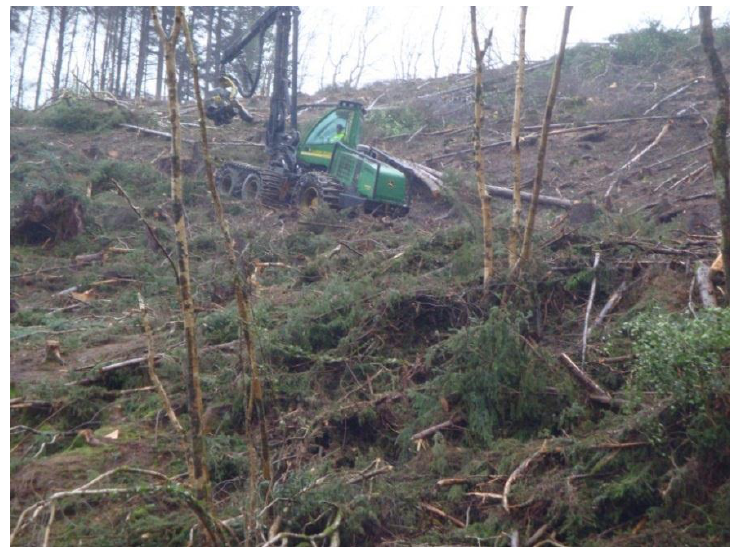
Figure 7. John Deere timber harvester 1410 D on Clonmel SC